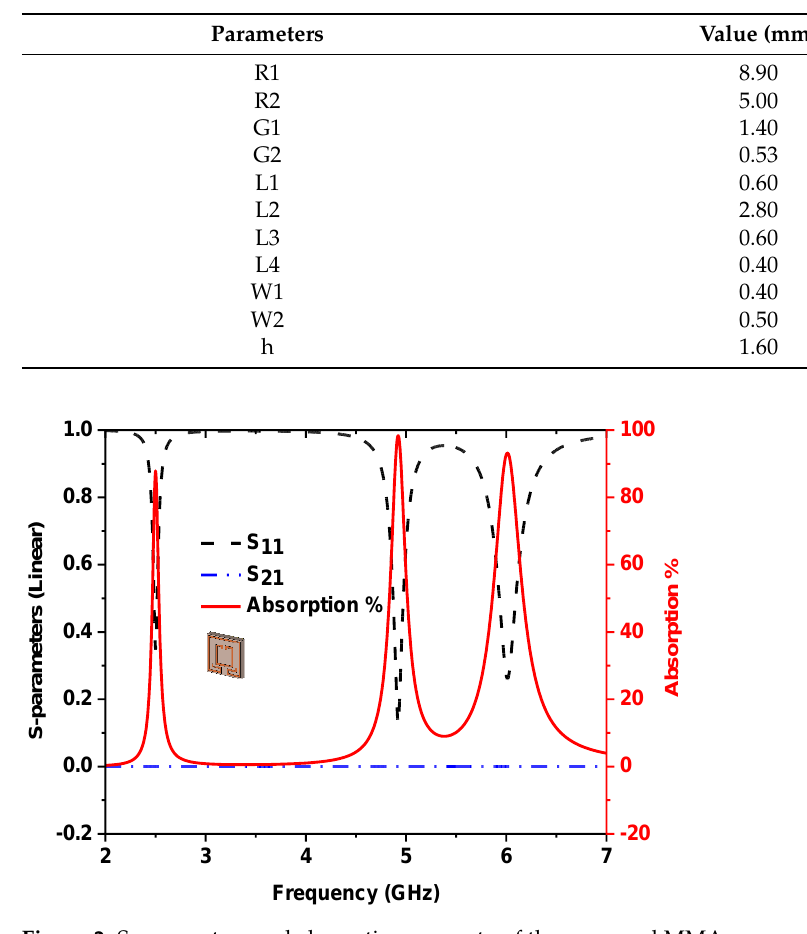
Figure 2. S-parameters and absorption property of the proposed MMA. Table 1. Parameter ’ s list of proposed MMA.